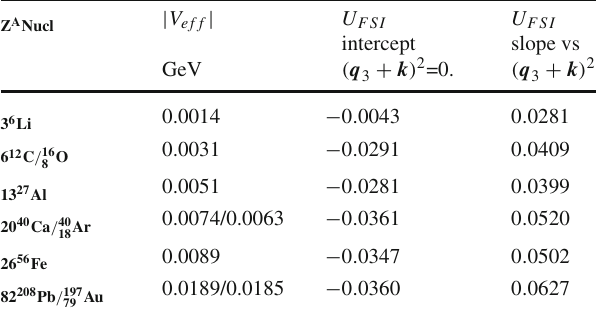
Table 9 The intercepts (GeV) at q 2 fits to U FSI versus ( q 3 + k ) 2 . The overall systematic errors on U FSI are estimated at ± 0.005 GeV